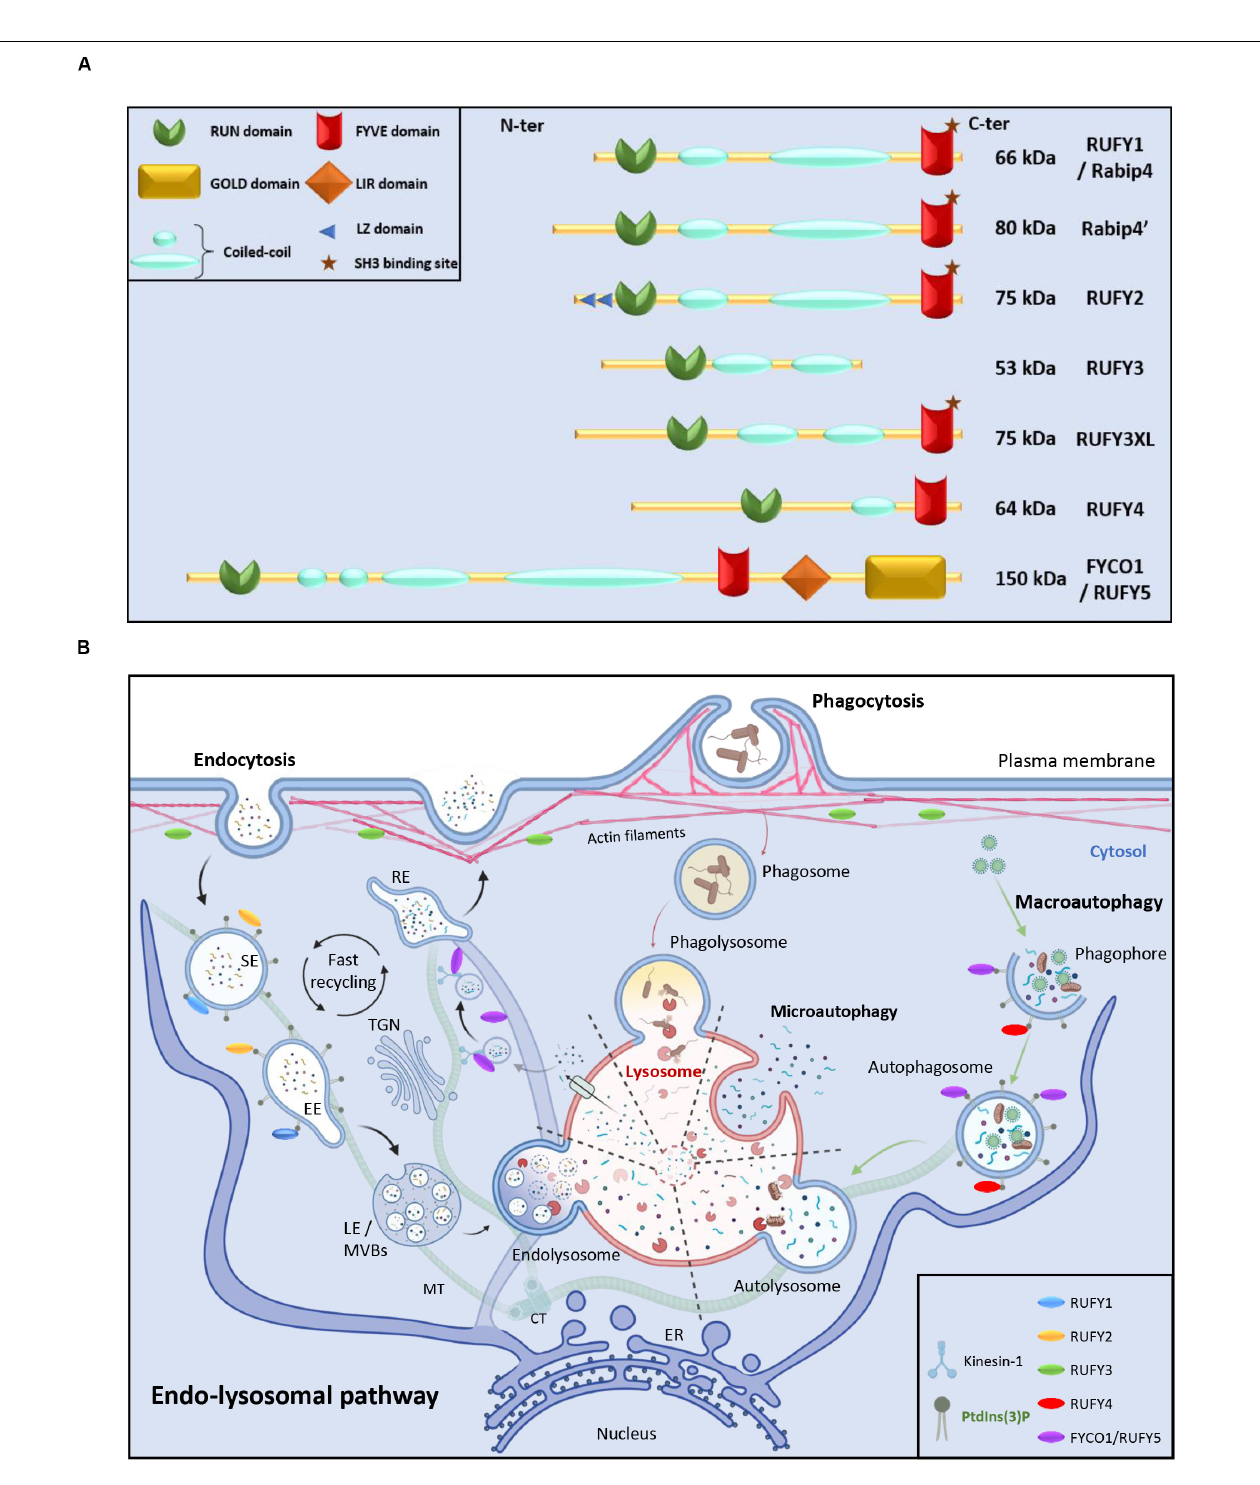
FIGURE 1 | RUN and FYVE domain containing-proteins in the endo-lysosomal pathway. (A) Schematic representation of the RUFY proteins family. (B) Description of the endo-lysosomal and autophagy pathways and presumed functional locations of RUFY proteins. Extracellular material is ingested by endocytosis or phagocytosis. The action of different endosomes allows cargo to be sorted, recycled or degraded in a complex and regulated process involving fusion, maturation and transport along the cytoskeleton. Alternatively, during autophagy, obsolete components present in cytosol are captured in autophagosomes prior fusion with lysosomes and degradation (macroautophagy) or directly internalized through endosomal invagination (microautophagy). SE, sorting endosome; EE, early endosome; TGN, trans golgi network; LE, late endosome; MVBs, multi vesicular bodies; RE, recycling endosome, MT, microtubule; CT, centrioles; ER, endoplasmic reticulum. The location of PI3P and RUFY proteins known activity is shown. Created with BIoRender.com.